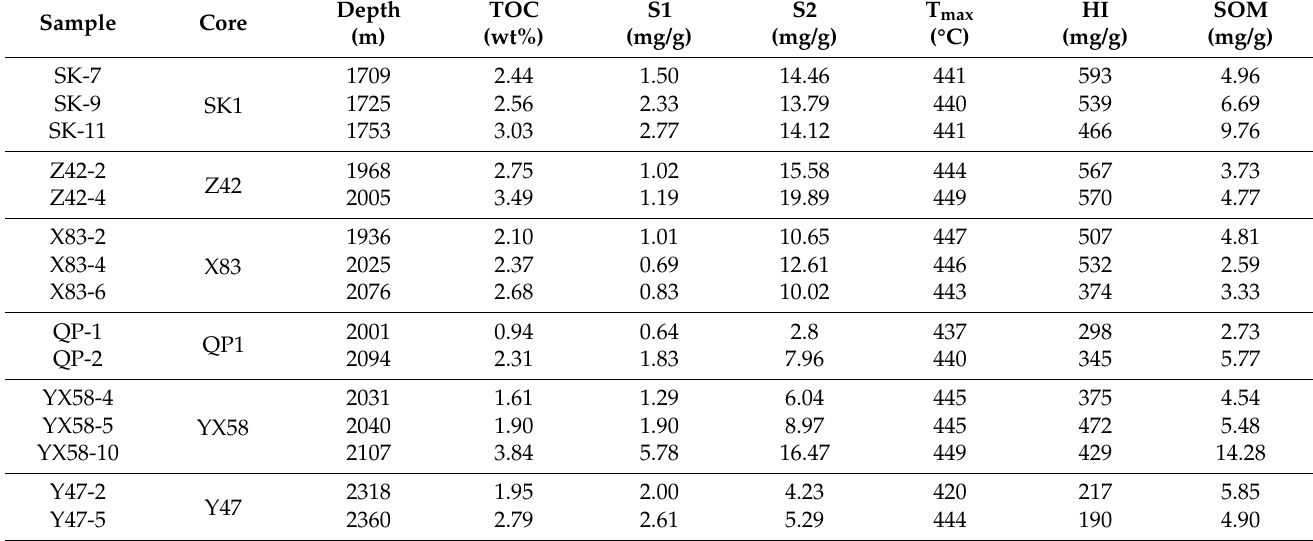
Table 1. TOC, soluble OM contents and pyrolysis parameters of the Qingshankou Formation shales in Songliao